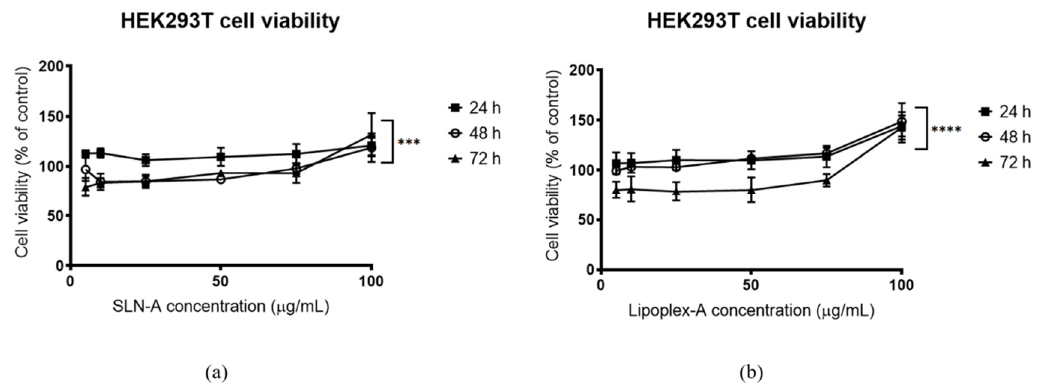
Figure 5. Viability of human embryonic kidney (HEK)293T cells treated with ( a ) SLN-A nanoparticles; ( b ) lipoplex-A (SLN-A with loaded plasmid DNA) for 24, 48 or 72 h. Cell viability increased across both treatments in a dose dependent manner across all three timepoints. Cell viability was lowest for cells treated with lipoplex-A for 72 h. Two-way ANOVA confirmed that a significant difference in cell viability was observed between timepoints for cells treated with both SLN-A (F(1.279, 15.35) = 21.24, P = 0.0002) and lipoplex-A (F(1.222, 14.66) = 32.56, P = < 0.0001). *** denotes P ≤ 0.001, and **** denotes P ≤ 0.0001.